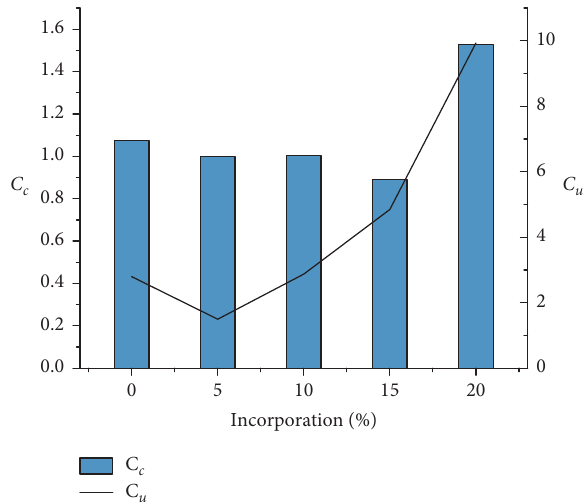
Figure 10: Particle size grading curve of red clay samples doped with different contents of calcium